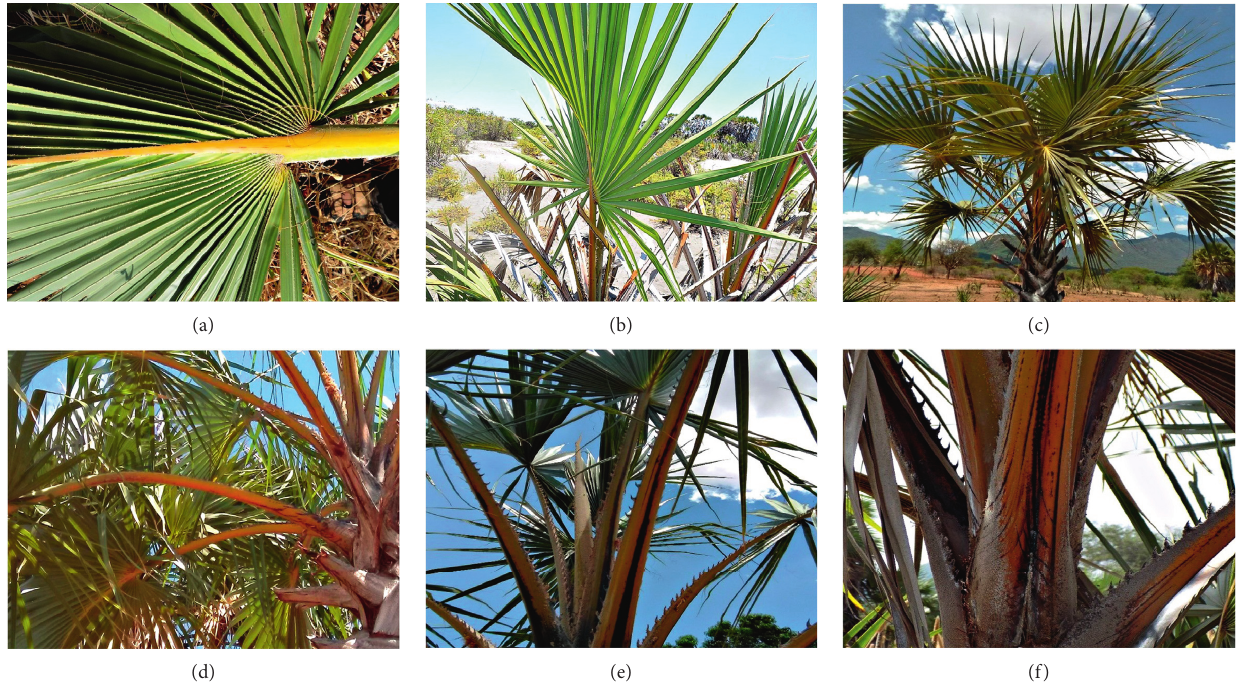
Figure 3: H. compressa leaf and petiole morphology. (a–c) Curved costa of H. compressa . (d) Long thin petioles observed in Kwale. (e) Petiole colour (yellow with black stripe) in Tana River. (f) Stout leaf base morphology was observed in all H. compressa trees.